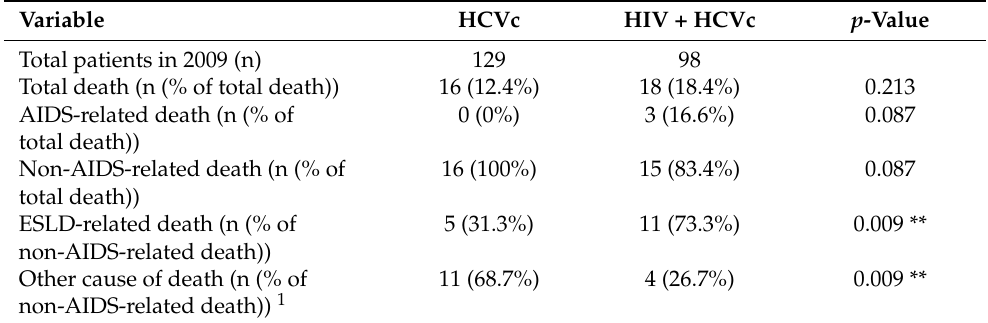
Table 2. Mortality rates in HCV mono-infection and HCV/HIV coinfected patients from 2009 to 2017.